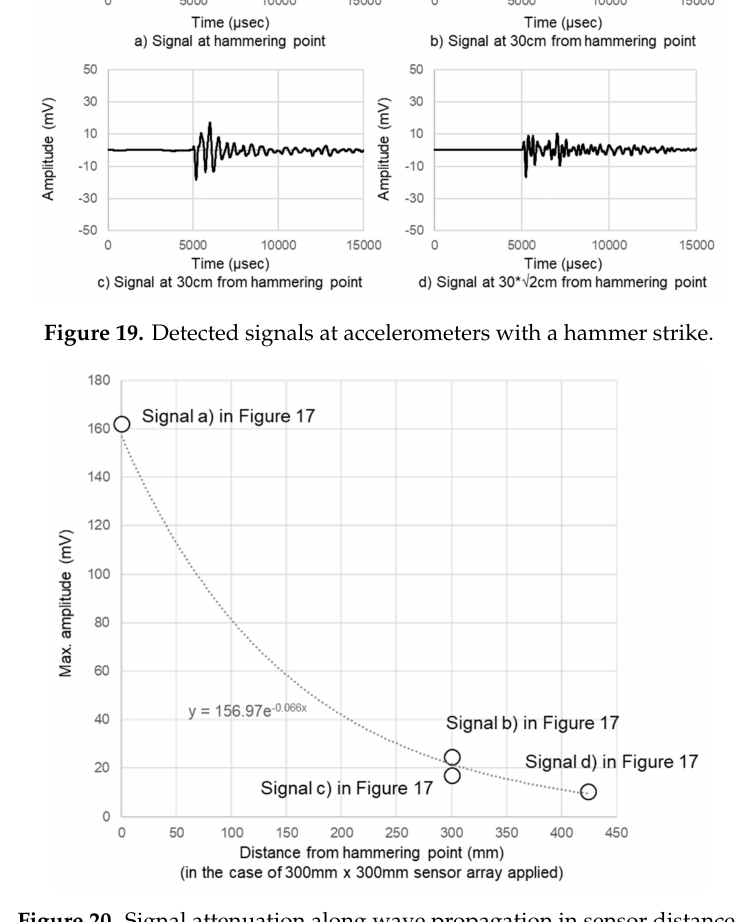
Figure 20. Signal attenuation along wave propagation in sensor